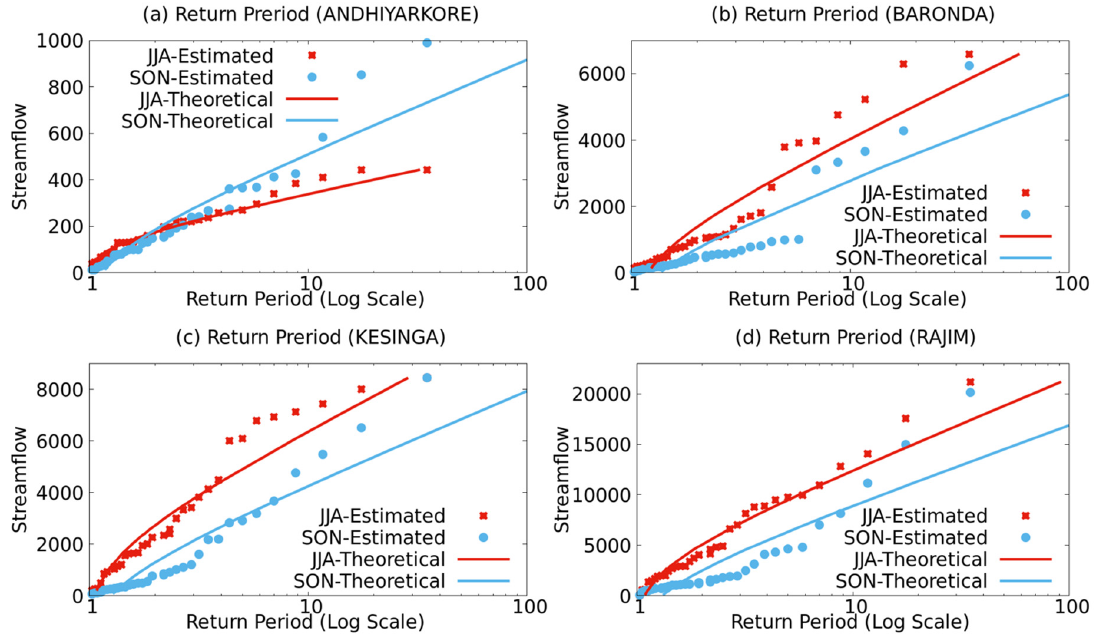
Figure 8. Return period of annual JJA and SON maximum streamflow (m 3 s − 1 ) with respect to Weibull plotting position (estimated) and Gumbel distribution (theoretical).